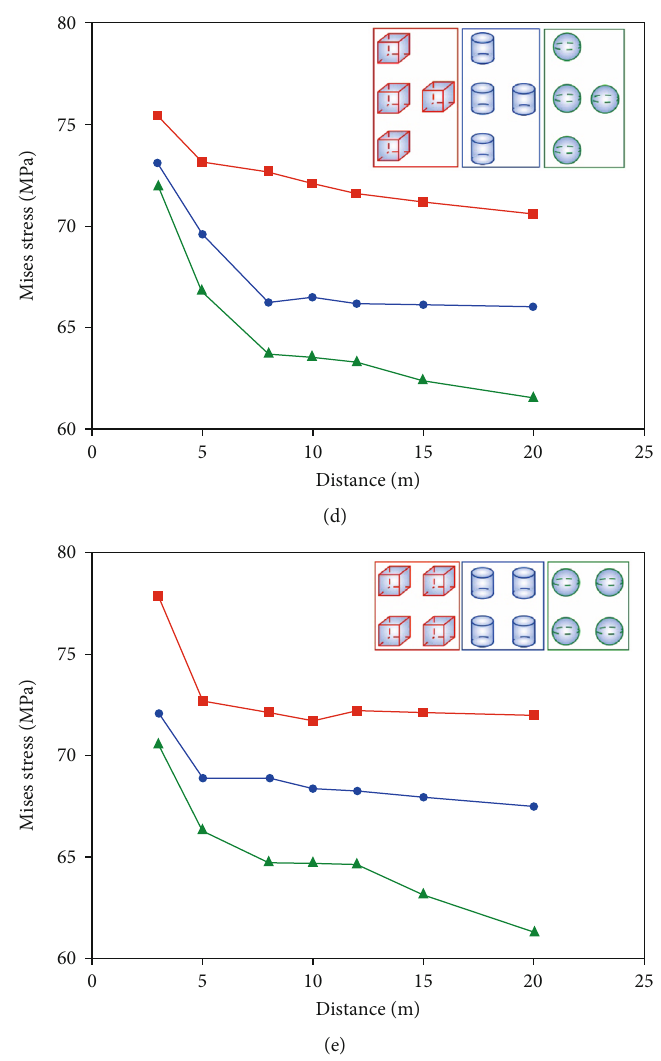
Figure 8: Mises stress variation diagram for the combination patterns of multiple